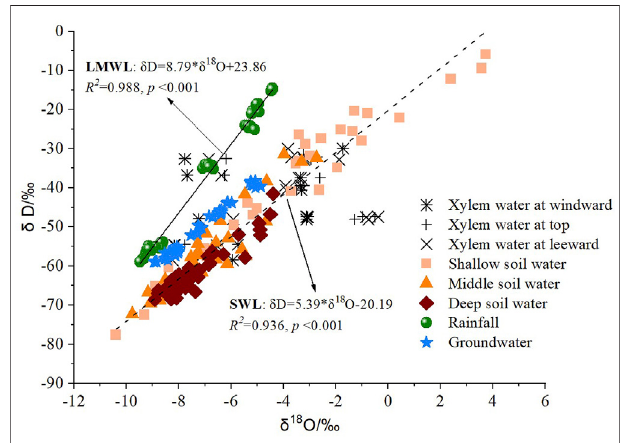
FIGURE 7 | Linear regression of δ D and δ 18 O values in different water pools in the study site.